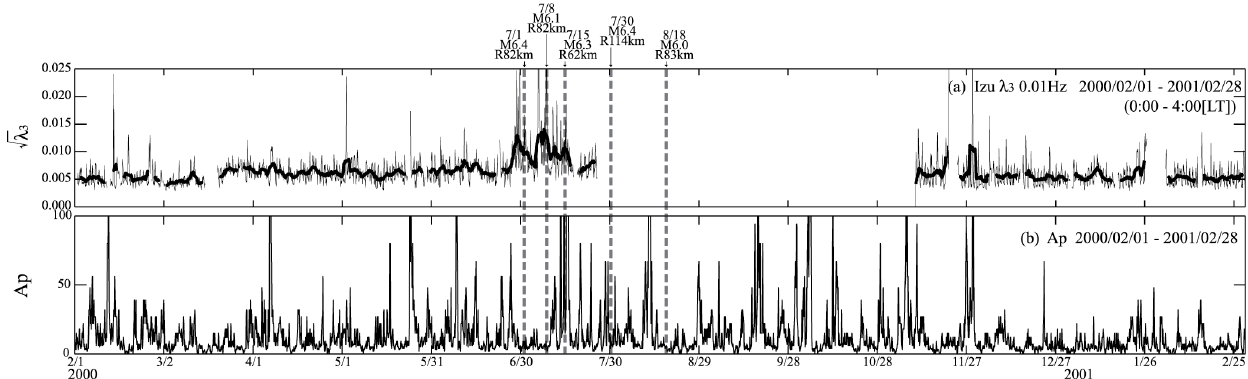
Figure 5. Result of principal component analysis with the use of the H component data observed at three stations. The upper panel indicates the temporal evolution of the third principal component (